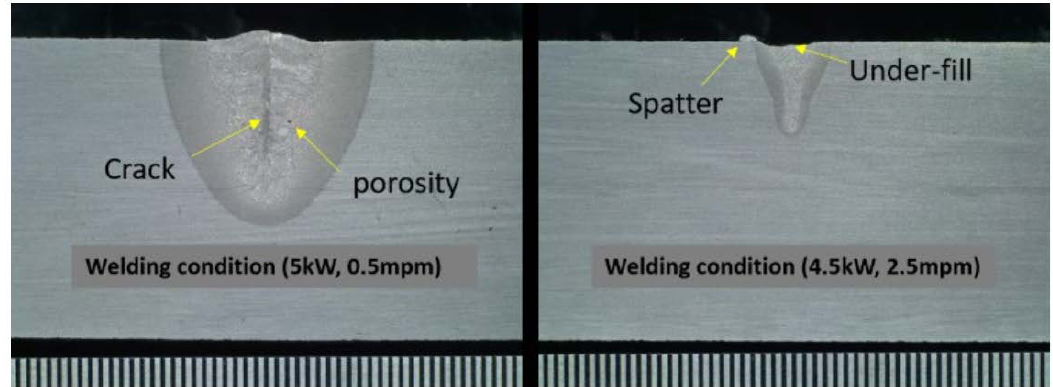
Figure 8. Crack, porosity, spatter and under-fill of A553-1 after laser welding.